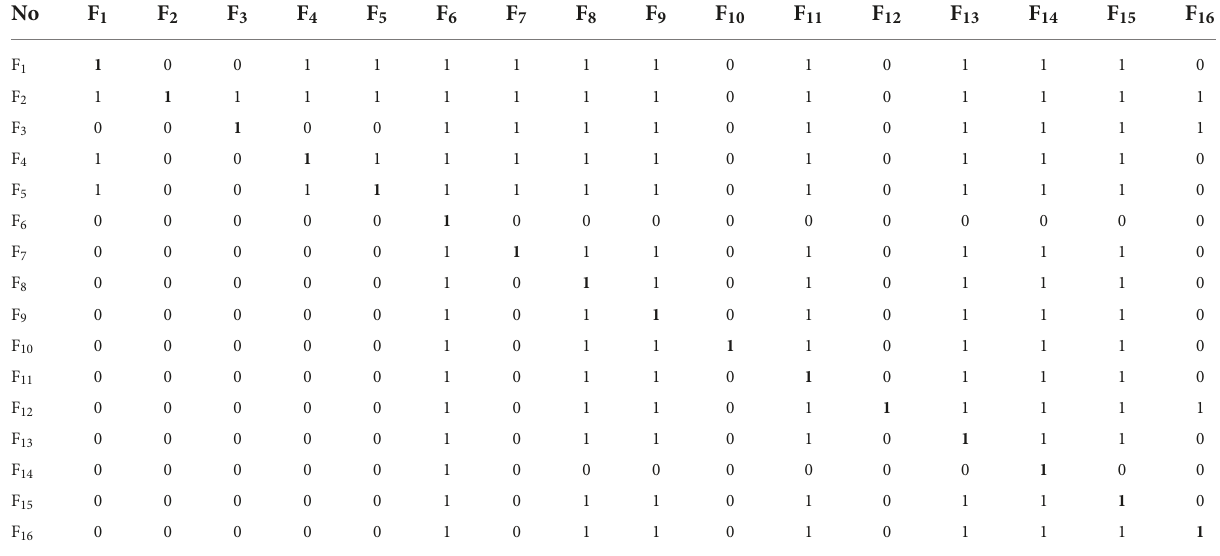
TABLE 5 Reachability matrix R of 16